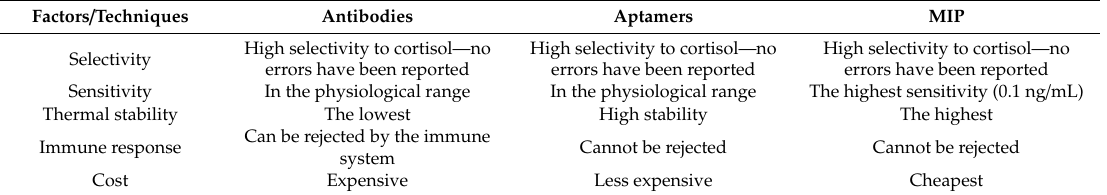
Table 3. Comparison between three cortisol detection techniques over several